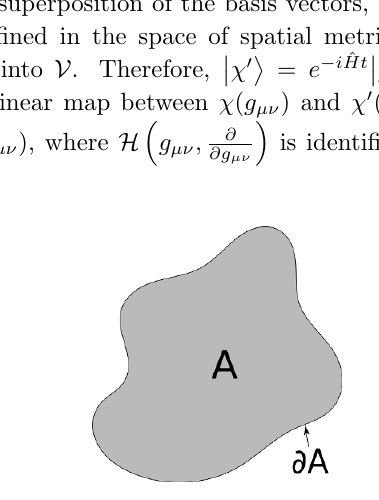
Figure 2 . A metric is associated with each basis state in V such that the von Neumann entan- glement entropy of a region A is proportional to the proper area of @A measured with respect to the